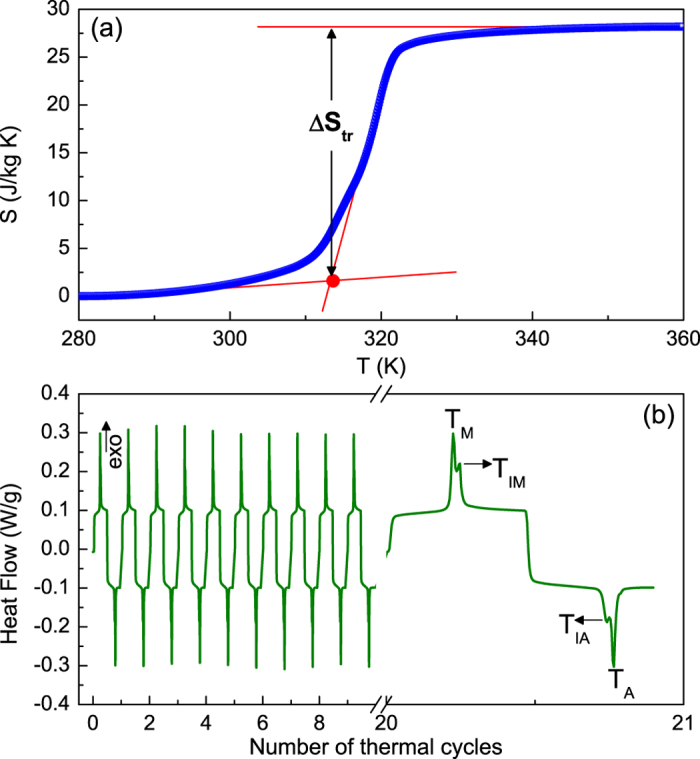
(a) The entropy as a function of temperature during the multiple transformations at zero fields in Ni55.8Mn18.1Ga26.1 alloy. (b) Heat flow data of thermal cycling with 21 times around the multiple transformations for this sample.